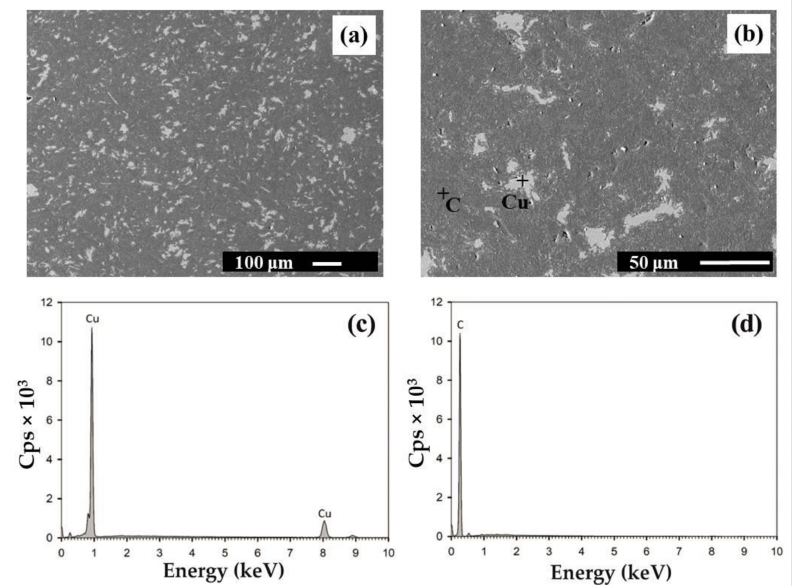
Figure 3. SEM microstructure of the Cu–graphite sample with 90 vol. % graphite at magnification 100 × ( a ) and 500 × ( b ). Cu and graphite are colored in light and dark grey, respectively. EDS spectra were obtained by point analysis in Cu ( c ) and C ( d ).